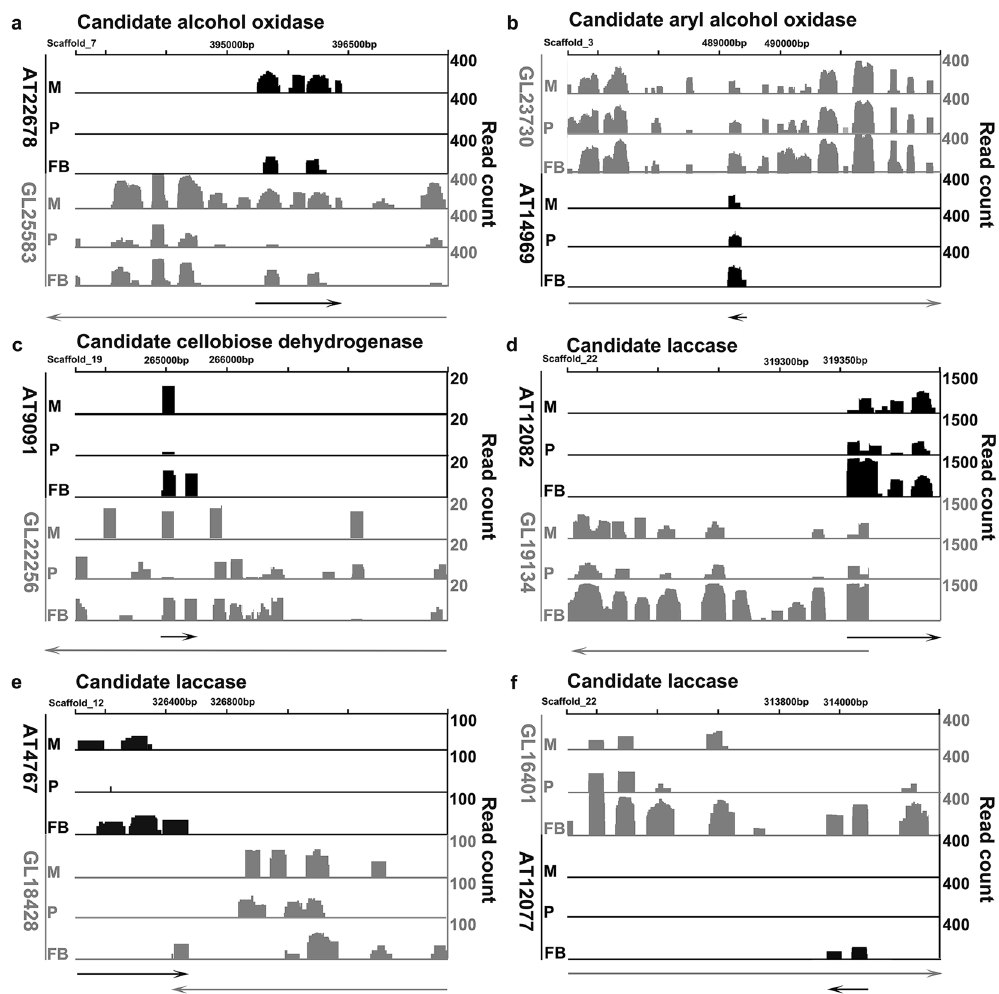
Figure 5. Gene structures and relative expression levels of the six SATs involved in lignin degradation. For each panel, the “X” axis shows the chromosomal region with the scaffold number and coordinates, while the “Y” axis shows the read counts. The transcript expressed on the positive strand is shown on the top and the transcript expressed on the negative strand is shown on the bottom. The read counts for the STs are shown in black and those for the ATs are shown in gray. The name of enzyme encoded by the ST was shown above each panel. The names for the ST and NAT were shown to the left of each panel. The details of the genes can be found in Table S9. M: mycelia; P: primordia; FB: fruiting